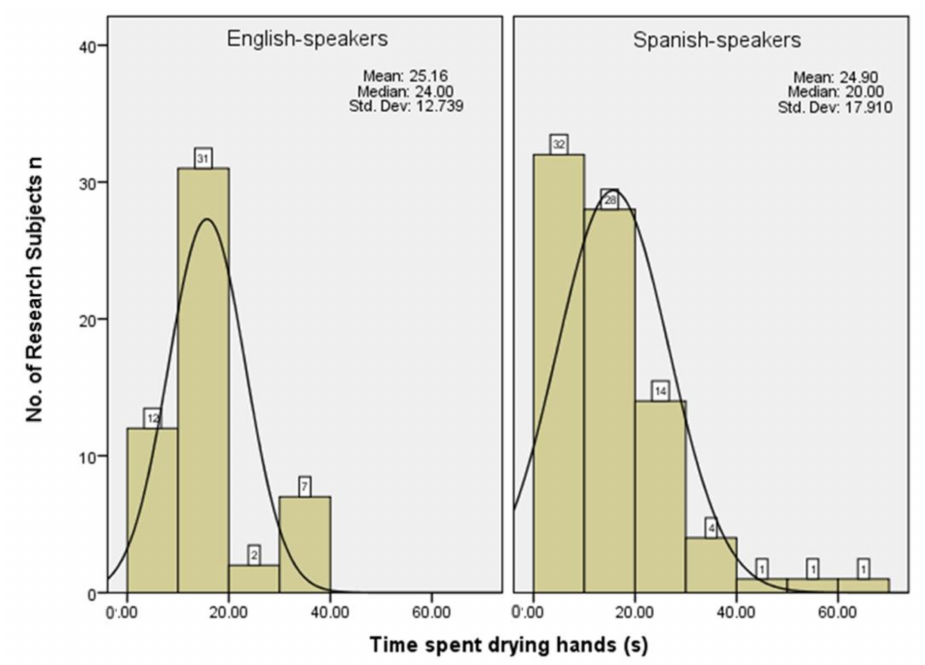
Figure 2. Self-reported hand drying times for UK and Spanish research